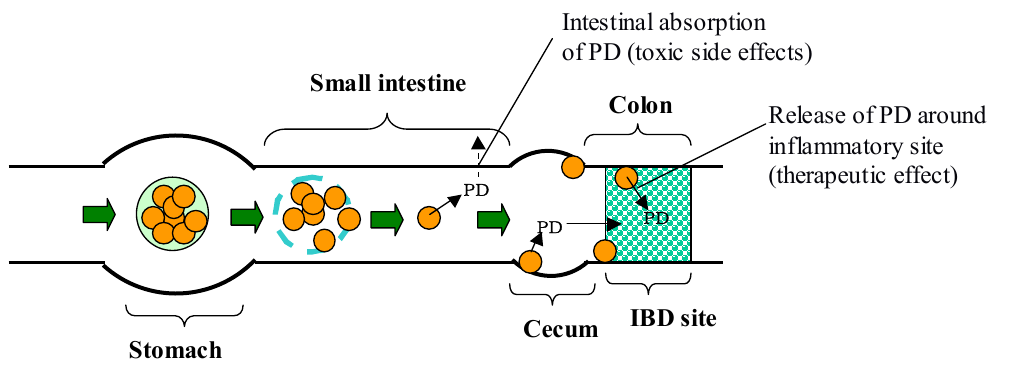
Figure 7. Gastrointestinal transit and PD release after oral administration of Ch-SP-MS/EuL.